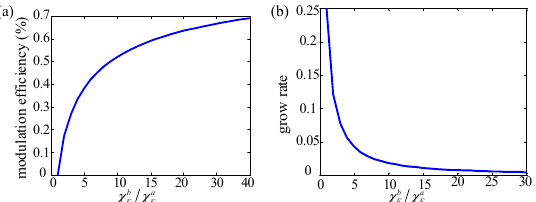
Figure 3. ( a ) The modulation e ffi ciency as a function of the magnetic susceptibility modulation ability of FMF, M.; ( b ) the grow rate of the modulation e ffi ciency as a function of the magnetic susceptibility modulation ability of